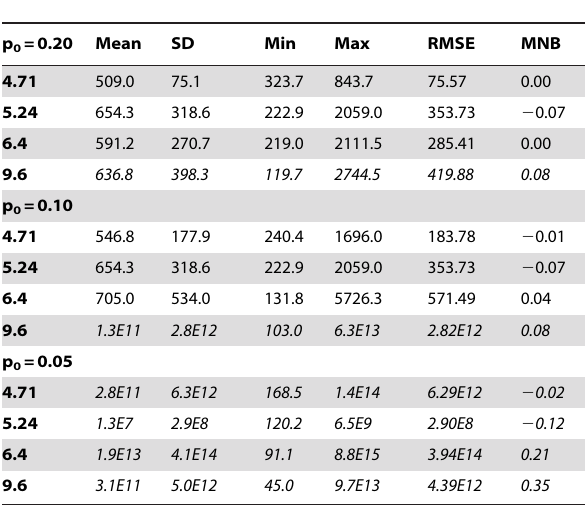
Table 6. For s =1 km, summary estimates of ^ ss in the regular trap configuration when trap spacing increased from 4.71 to 9.60 km (J=128 to 32 traps) and N=500.